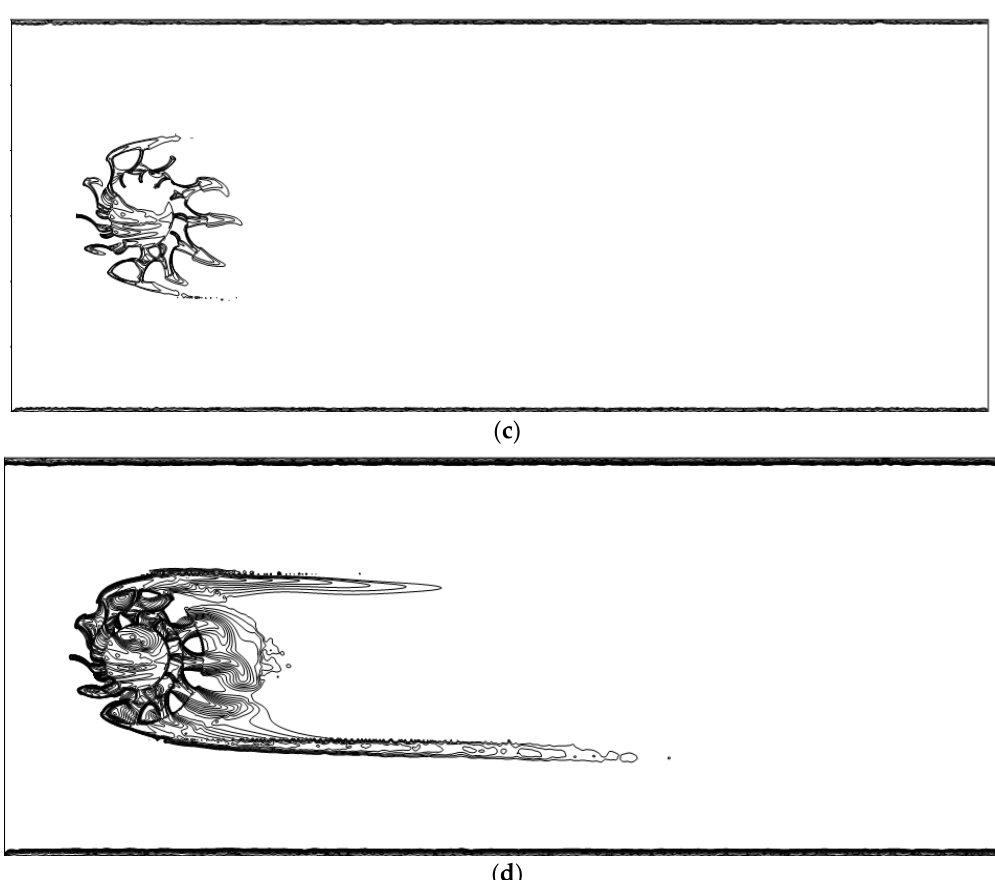
Figure 4. Spatial distribution of ( a ) a r , ( b ) lo/ Δ ≥ 1.25, ( c ) lo/ Δ ≥ 4.8, and ( d ) lo/ Δ ≥ 12.5 within the flow domain.